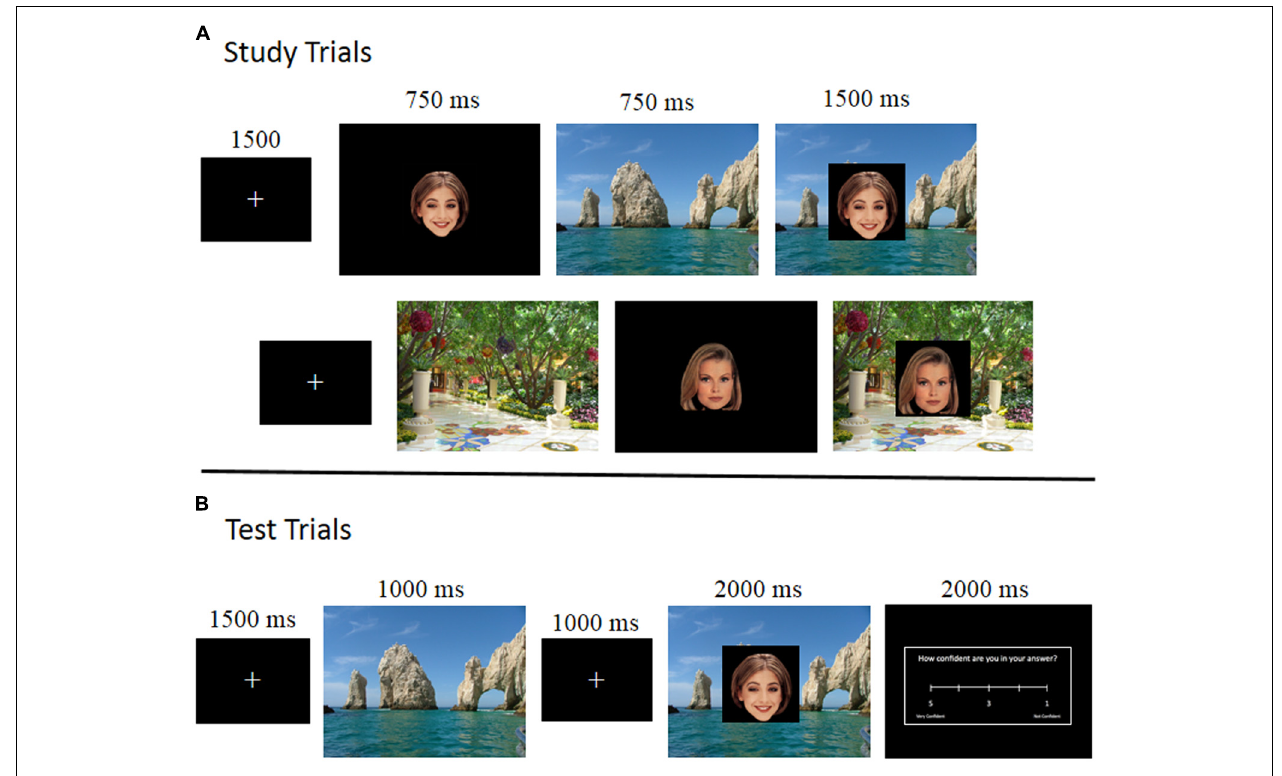
FIGURE 1 | Schematic representation of the experimental paradigm, illustrating the sequence of stimuli during study (A), where the top row represents a face-first trial and the second row